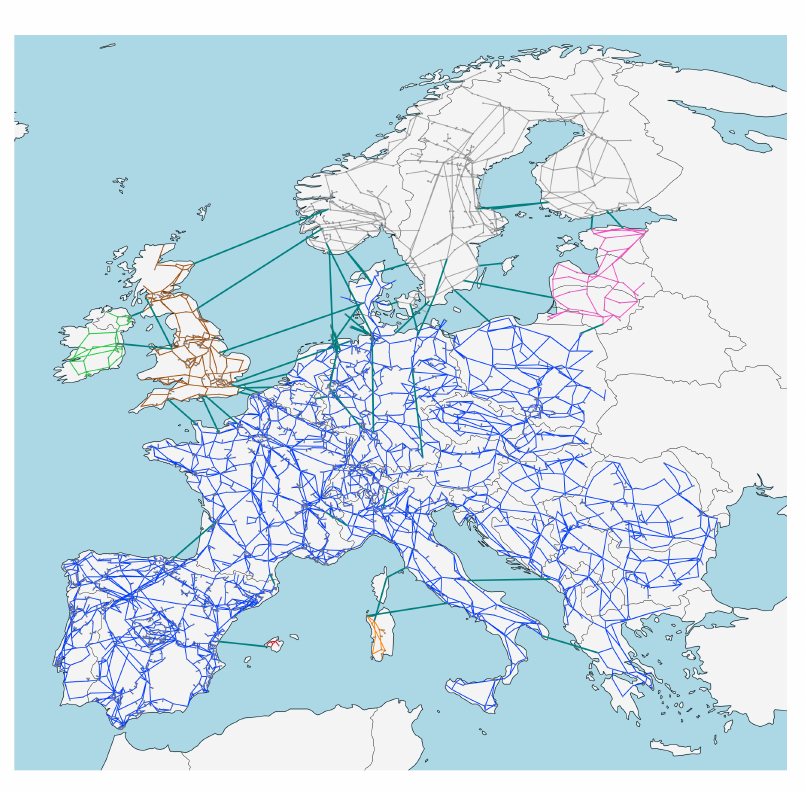
Figure 3. The different synchronous zones of the European power system, as indicated by the different colors. Whereas the Continental European grid is the largest subnetwork, Ireland, the United Kingdom, Scandinavia (with only parts of Denmark), and the Baltic region have their own synchronous zones. These areas are interconnected via DC lines ( dark green